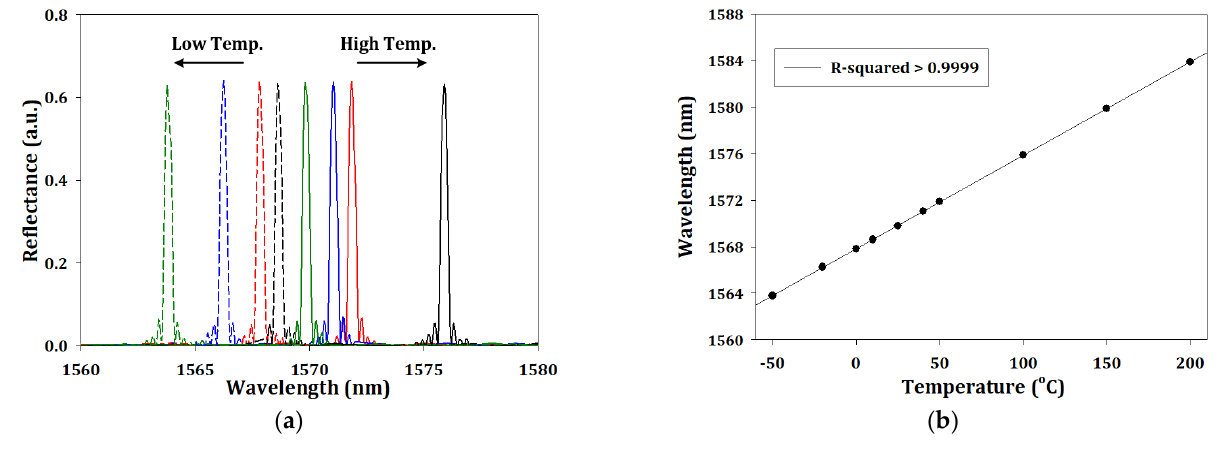
Figure 6. ( a ) The simulation output spectrum and ( b ) the trends in different peak wavelengths with different environmental refractive index.